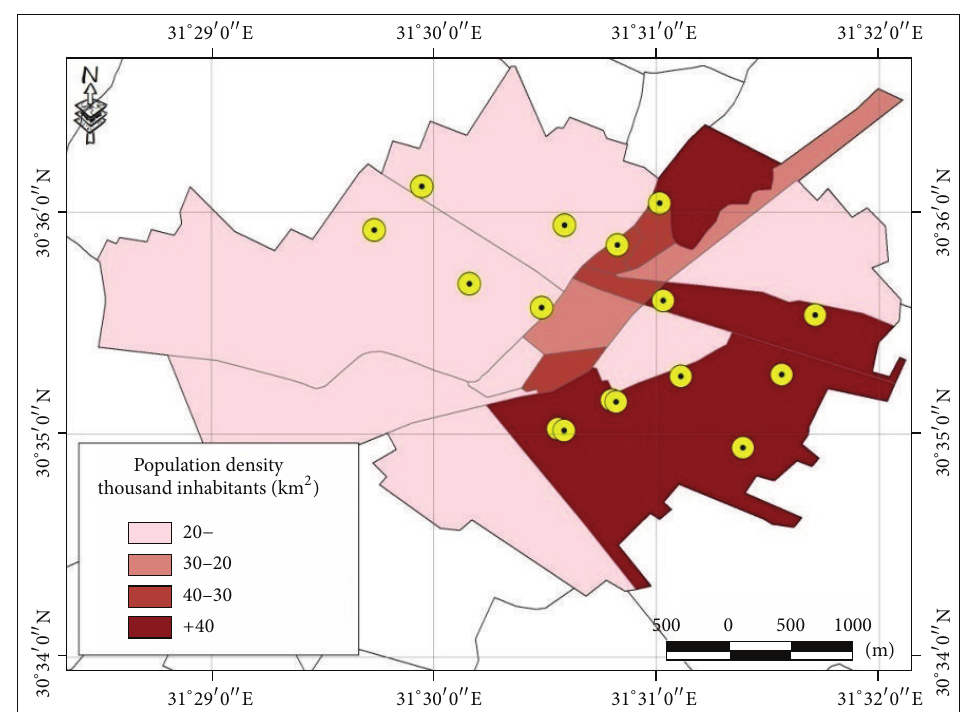
Figure 2: The positive E . coli isolates in relation to population density of different regions of Zagazig city.